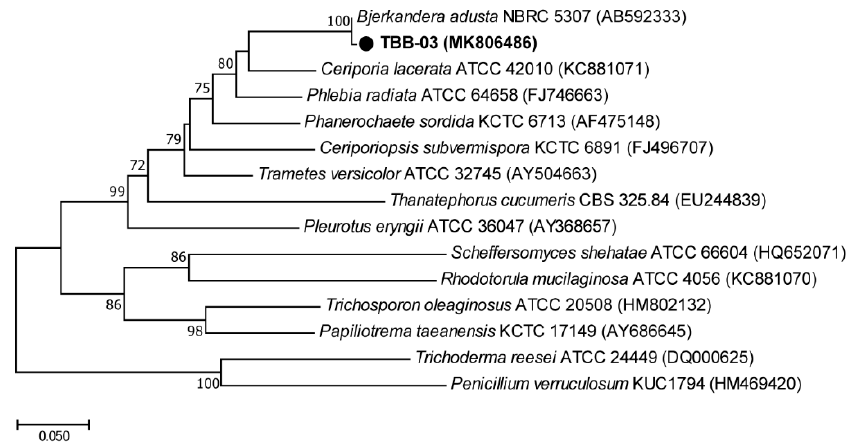
Figure 1. Phylogenetic tree for TBB-03 and related strains based on internal transcribed spacer (ITS) gene sequences. Phylogeny of TBB-03 generated from neighbor-joining analysis of ITS sequences. The scale bar corresponds to 0.05 substitutions per nucleotide position.